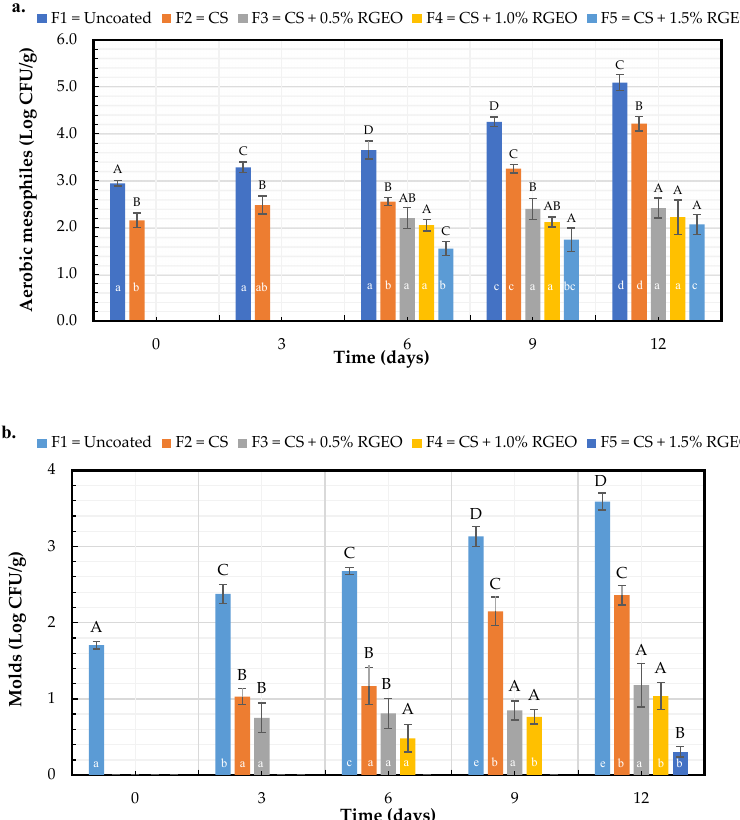
Figure 9. Effect of treatments on the concentration of: ( a ) aerobic mesophilic, ( b ) counting of molds and yeasts in pears with CS + RGEO treatments: F1 = uncoated, F2 = CS, F3 = CS + RGEO 0.5%, F4 = CS + RGEO 1.0%, and F5 = CS + RGEO 1.5%. According to the ANOVA test, mean values and intervals of Duncan test for treatments and Fisher for days with 95%. Different lowercase letters (a, b, c) indicate significant differences between days according to the LSD Fisher test for each treatment in a confidence interval of 95%. In contrast, different uppercase letters (A, B, C) indicate significant differences between treatments for each day according to the Duncan test in a confidence interval of 95%. The statistical analysis indicated a significant difference ( p < 0.05) during the storage time for F1 (Figure 9 B). However, F2 was statistically equal between days 3 and 6, and 9 and 12. From day 3, the formulations presented significant differences concerning the control; on day 9, F4 had significant differences regarding F2, showing the RGEO of inclusion effect. On the last day of storage time, pears coated with F2 (CS) only presented a reduction of 1.2 Log CFU/g on day 12, F3 (CS + RGEO 0.5%), and F4 (CS + RGEO 1.0%) demonstrated 2.4 and 2.55 Log CFU/g reductions, respectively. F5 (CS + RGEO 1.5%) presented a reduction of 3.3 Log CFU/g in mold growth, indicating a potent antifungal